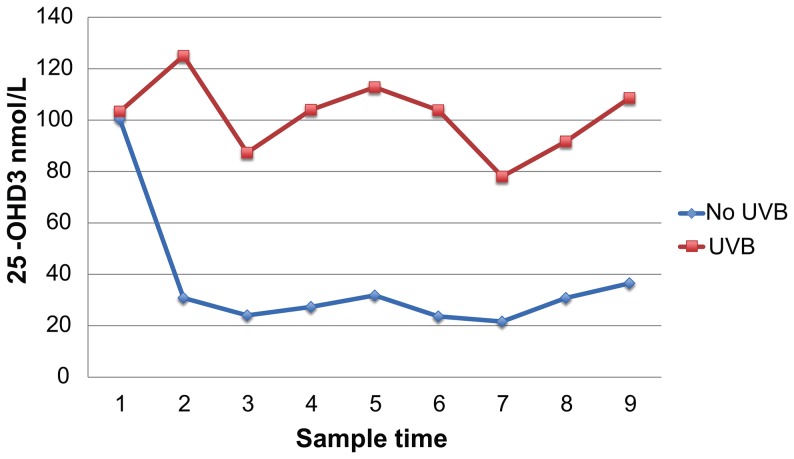
Serum 25-OHD3 in guinea pigs between groups over time (sample number).